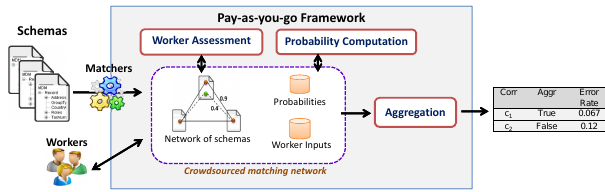
Figure 2. Architecture of the crowdsourced reconciliation